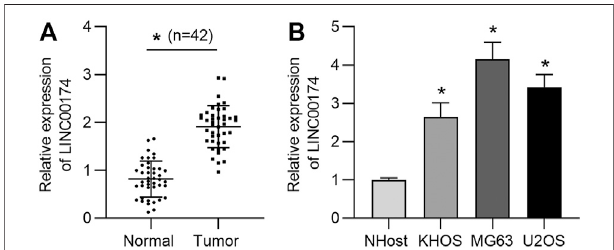
FIGURE 1 | LncRNA LINC00174 is upregulated in OS tissues and cell lines. (A) Theexpression ofLINC00174 in42OStissuesamplesandmatched adjacentnormaltissueswasmeasuredbyRT-qPCR. n (cid:2) 42.Signi fi cancewas analyzedbyStudent ’ st-test. (B) TheexpressionofLINC00174inOScell lines (KHOS, MG63, and U2OS cells) and the normal osteoblastic cell-line NHost was detected by RT-qPCR. Signi fi cance was analyzed by Student ’ s t-test. * p <